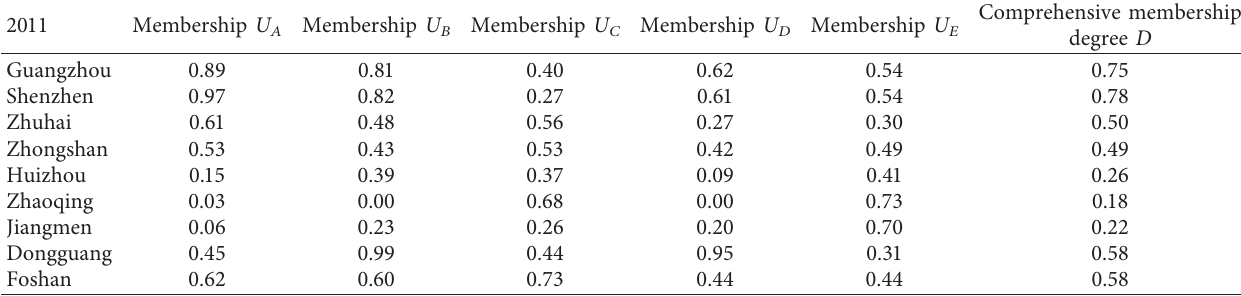
Table 10: First-level membership of the happiness index of nine cities in the Pearl River Delta in 2011.